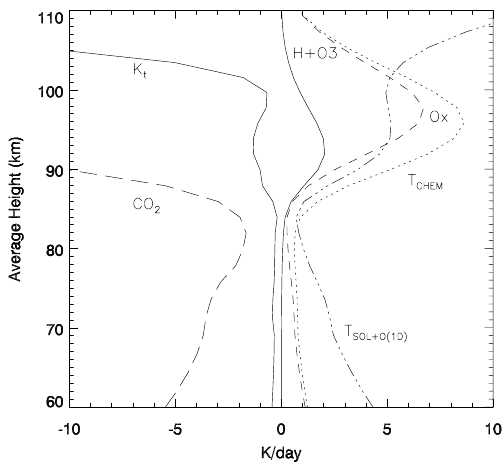
in some part due to changes in exothermic chemical heating.